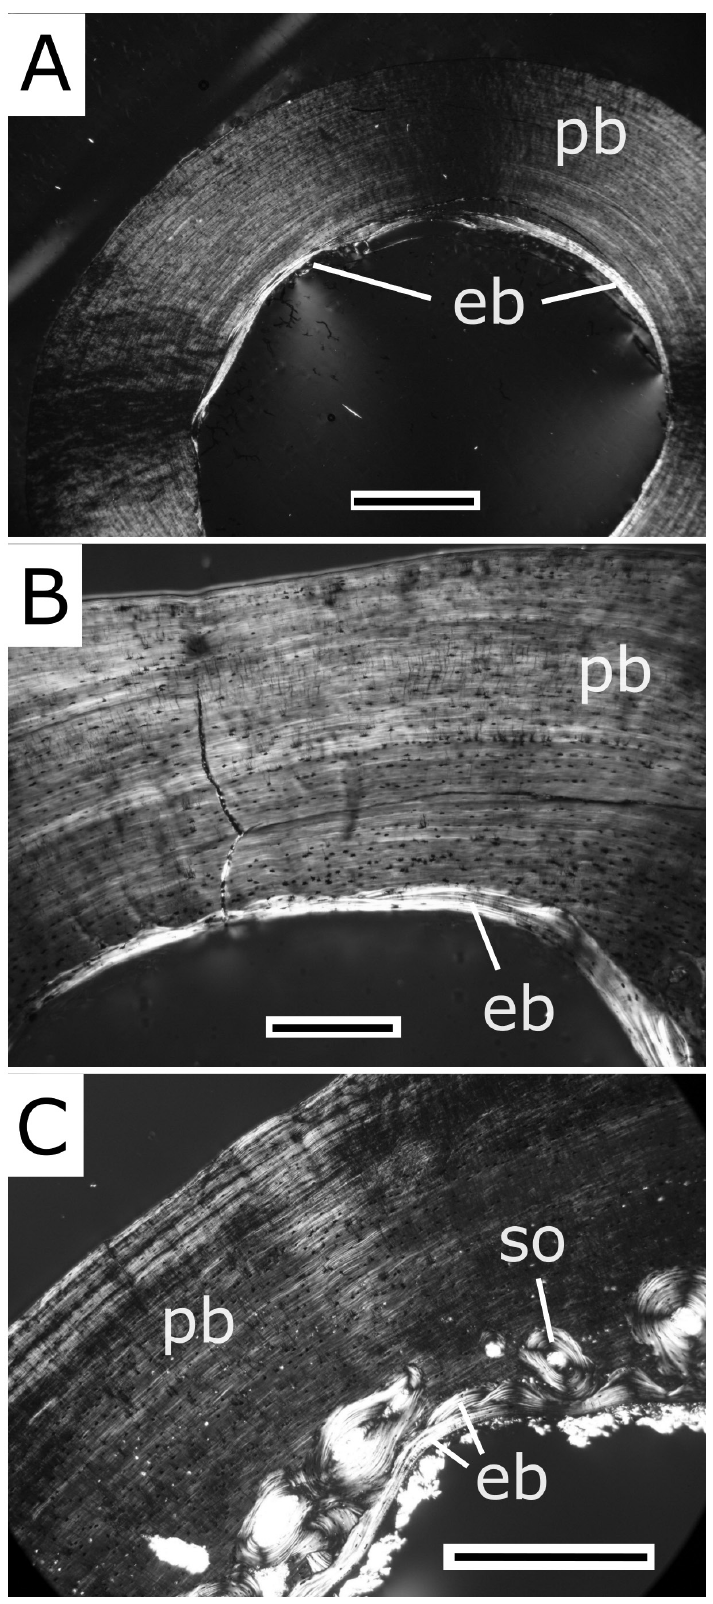
Figure 7. Lamellar bone histology and endosteal remodeling in other squamate lizards. (A) Cross section of an Iguana iguana femur (AC1896 288). (B) Cross section of a Varanus timorensis femur (MK52920). (C) Cross section of Tupinambis teguixin femur (MK53531). All images were taken under cross polarized light. Note the cross cutting relations in the endosteal bone of V. timorensis and Tupinambis . Also note the more extensive layer of remodeling with secondary osteons in the innermost cortex of Tupinambis . Abbreviations: eb – endosteal bone; pb – periosteal bone; so – secondary osteon. Scale bar in (A) equals 1 mm, in (B) 250 µ m, and in (C) 500 µ